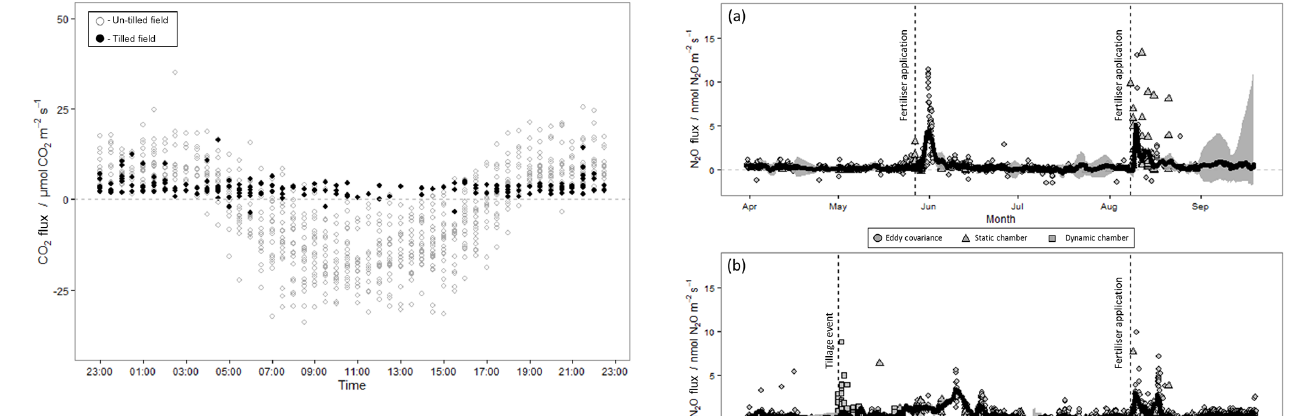
Figure 6. CO 2 flux measurements made from the untilled (grey) and tilled (black) fields between 1 May and 17 June. Uptake is denoted as a negative quantity. The results show a clear difference between the fields, with no daytime uptake on the tilled field. This implies that the high N 2 O fluxes measured after the tillage event can also be attributed to the tilled field.